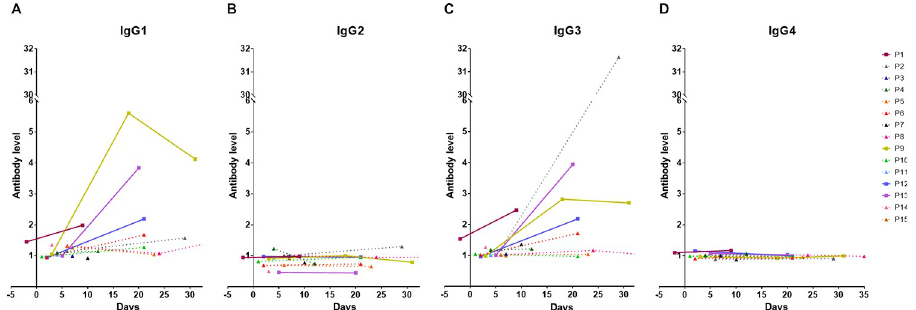
Fig 2. Longitudinal analysis of IgG subclasses of antibody responses to RBD in COVID-19 patients. Dynamic changes in RBD-specific IgG subclasses including IgG1 (A), IgG2 (B), IgG3 (C) and IgG4 (D) antibody response in individual COVID-19 patients (N = 15). Data are plotted by antibody response calculated as the ratio between OD of uncoated and coated antigen wells of an individual sample. Each line represents an individual subject. Solid line and square symbol represent pneumonia cases. Dot line and triangle symbol represent mild